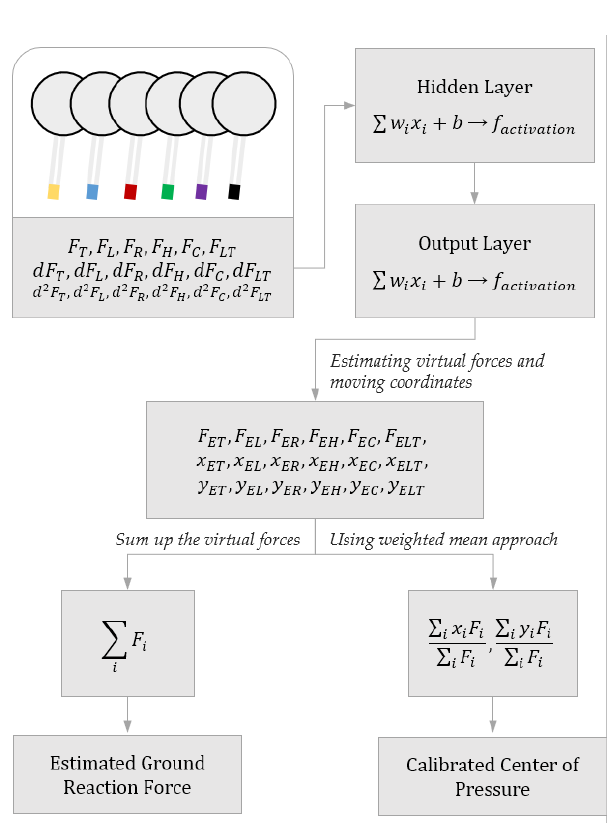
Figure 2. Flow chart of the ANN algorithm for estimating the GRF and calibrating the CoP of the insole.2.3. Artificial Neural Network